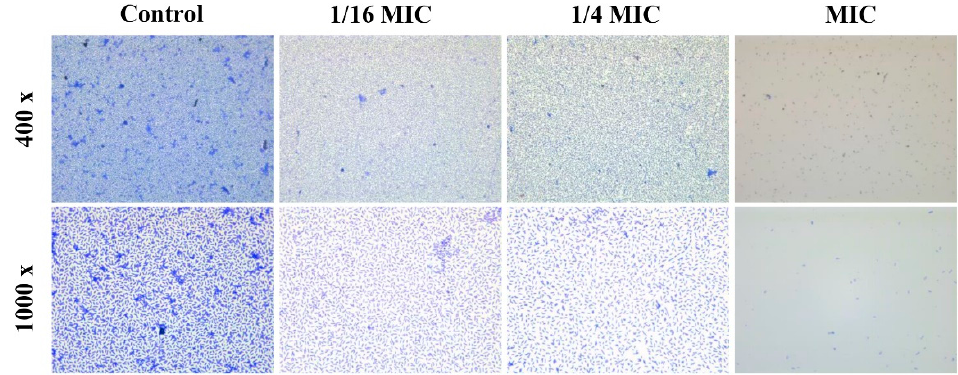
Figure 2. Microscopic analyses of A. hydrophila biofilm formation treated with carvacrol. The images were taken at magnifications of 400× and 1000×.